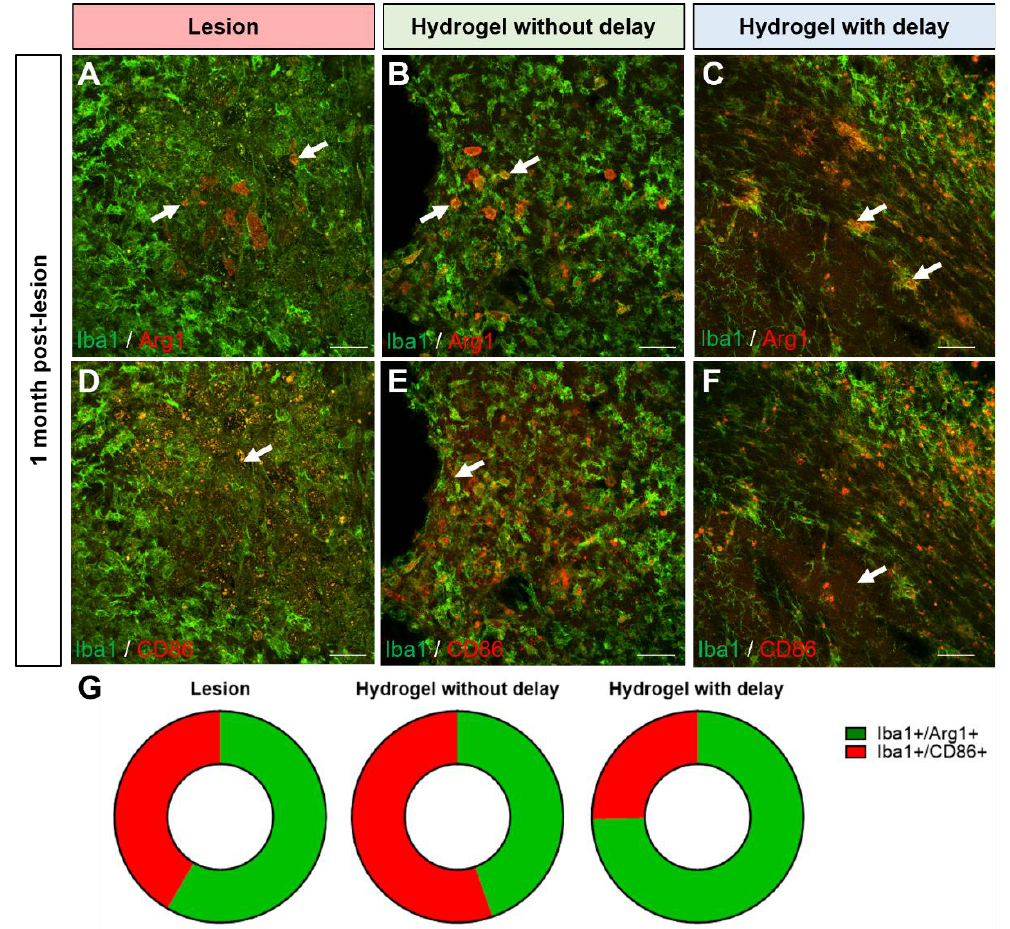
Figure 13. Anti and pro-inflammatory microglial cells in the cortex lesion one month after the le- sion/implantation. ( A – F ) Representative immunofluorescence staining of Iba1+ cells (green) colocal- ized with Arg1 (( A – C ), red) or CD86 (( D – F ), red) in lesioned ( A , D ) or in no-delay ( B , E ) or delay ( C , F ) hydrogel implanted groups. Arrows indicate colocalization. Scale bar: 20 μm. ( G ) Representation of pro (red) and anti (green)-inflammatory microglia subtype proportion per condition. One-way ANOVA per subtype.